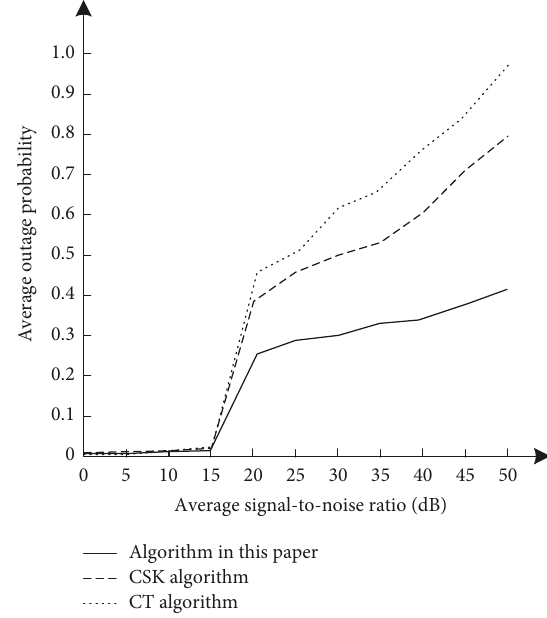
Figure 3: Comparison of average outage probability of different location